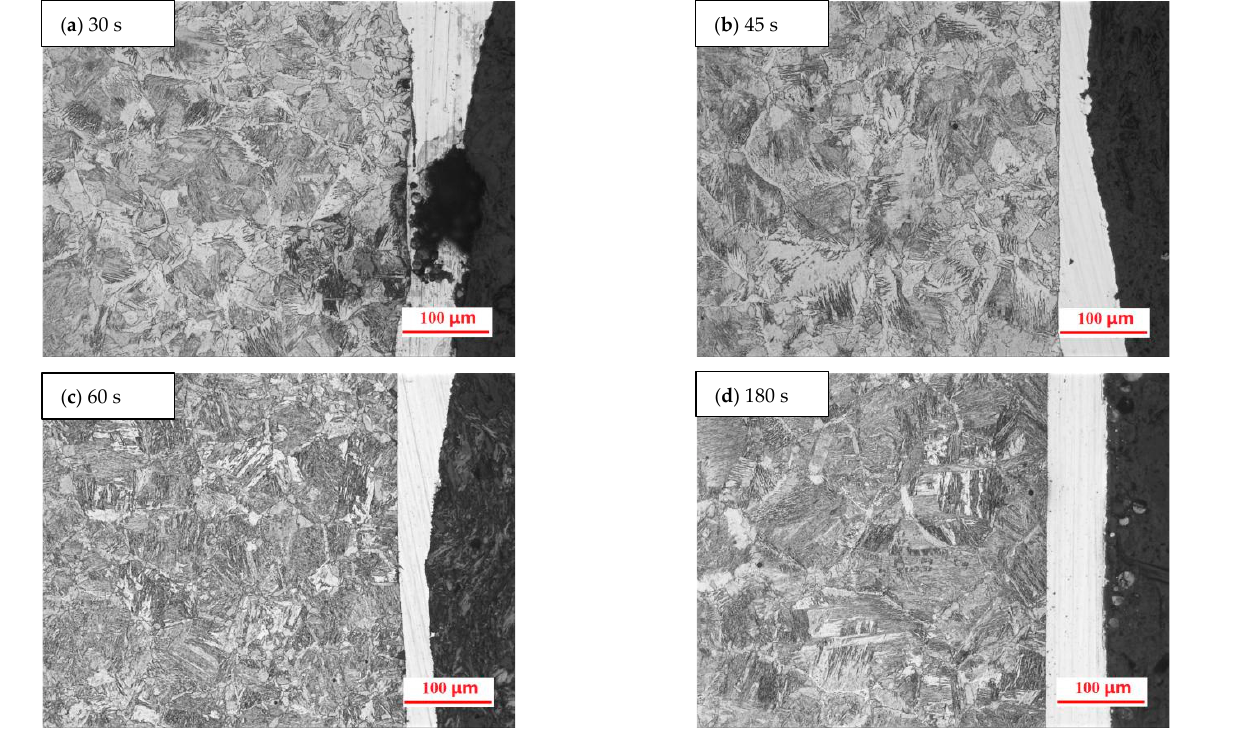
Figure 3. The microstructures of the Cu–steel interface with different hot-dipping times under 1125 °C.